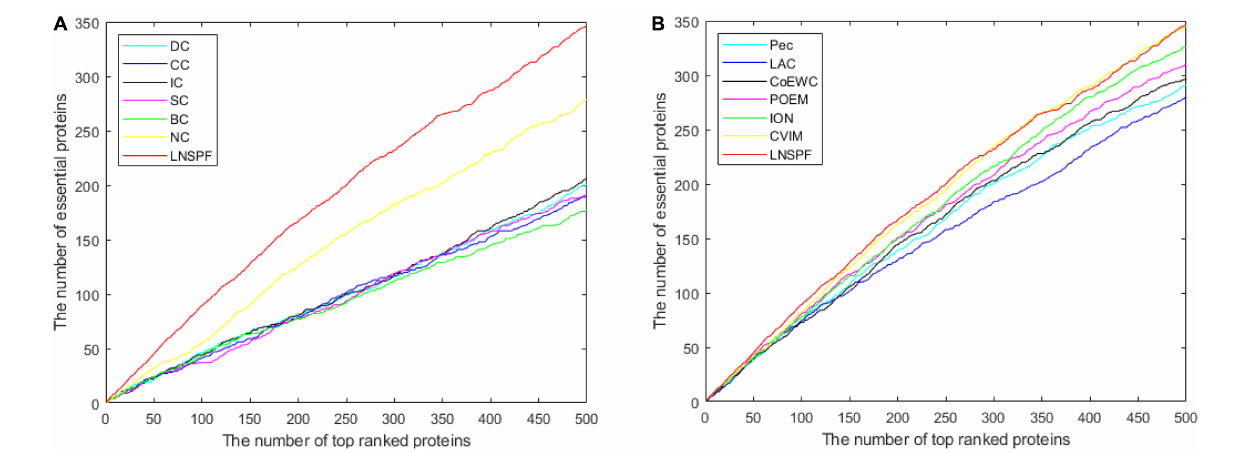
FIGURE 7 | The figure, respectively, shows the Jackknife curve of LNSPF and DC, CC, IC, SC, BC, NC, and PEC, LAC, COEWC, POEM, ION, and CVIM 12 prediction methods based on DIP data set. The X-axis represents the number of potentially critical proteins ranked in the top 500, and the Y-axis represents the number of truly essential proteins identified by these models. (A) Comparison between LNSPF and DC, CC, IC, SC, BC, NC. (B) Comparison between LNSPF and PEC, LAC, COEWC, POEM, ION,